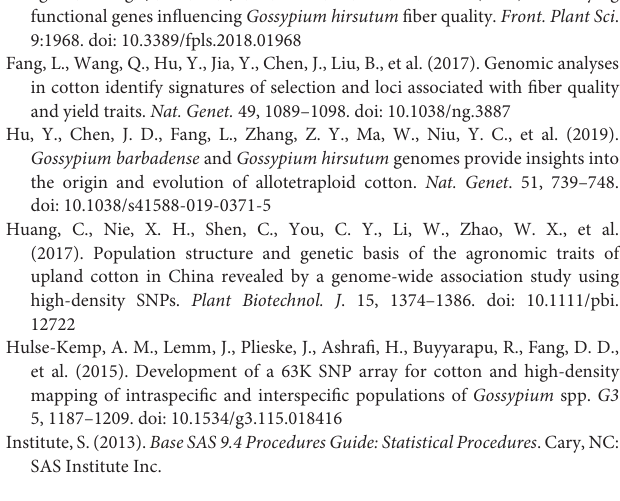
Supplementary Table 4 | The information of QTL and QTNs in the QTL interval.